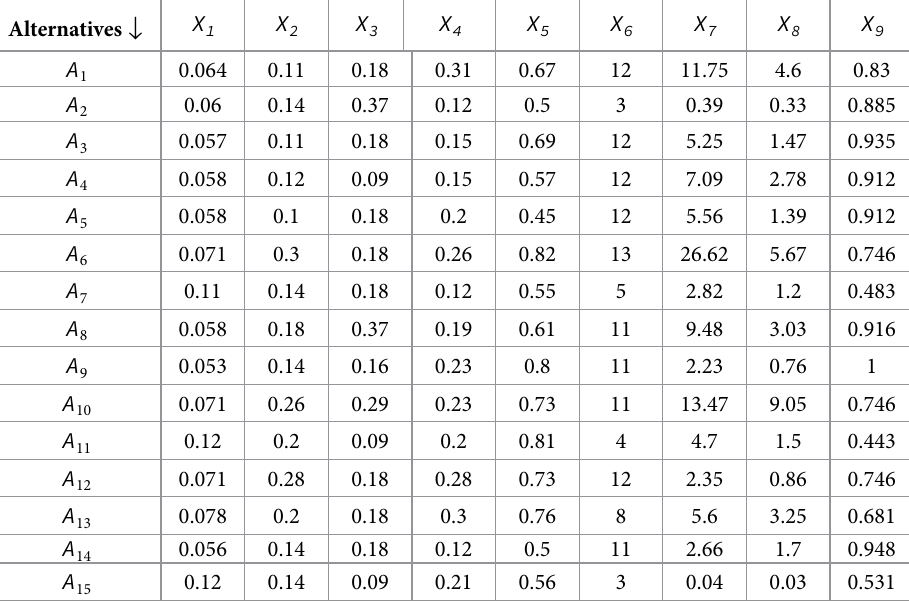
table 2. Initial decision making matrix of 15 contractors in Vilnius